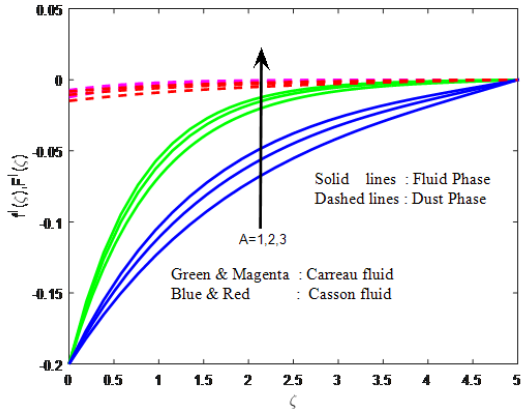
Fig. 9: Impact of A on velocity profiles.